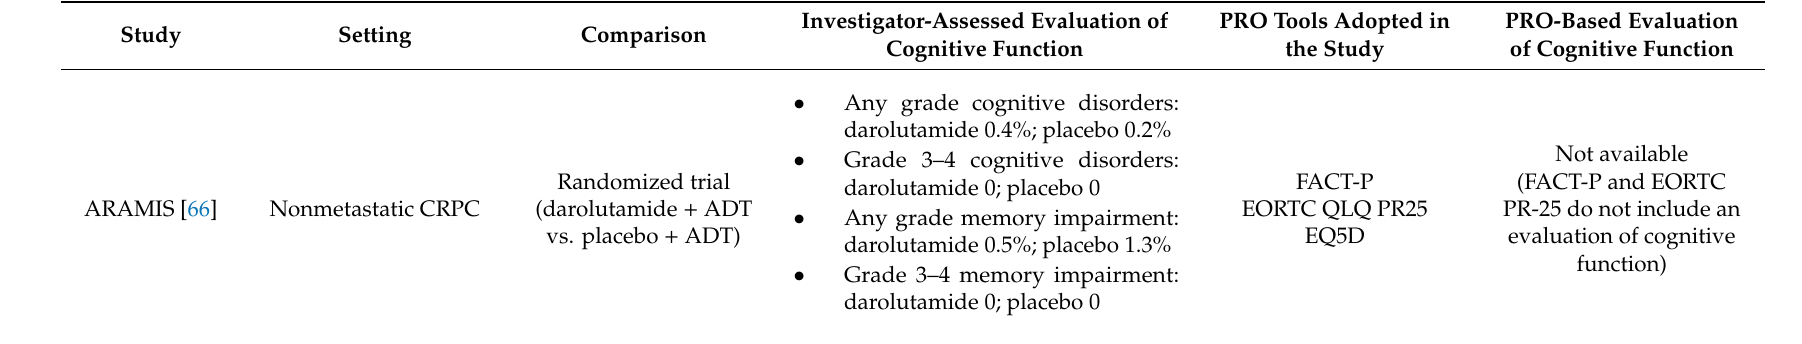
Table 5. Trials testing